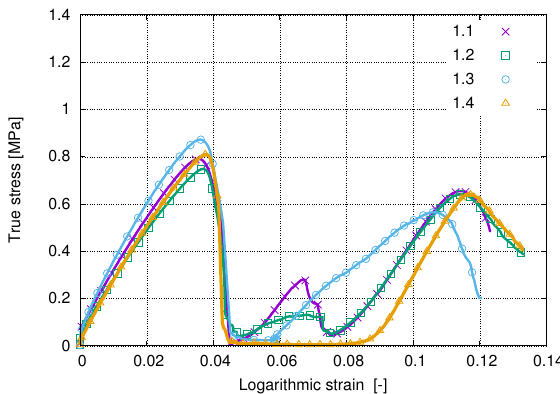
Figure 7. Stress-strain curves of specimens in group